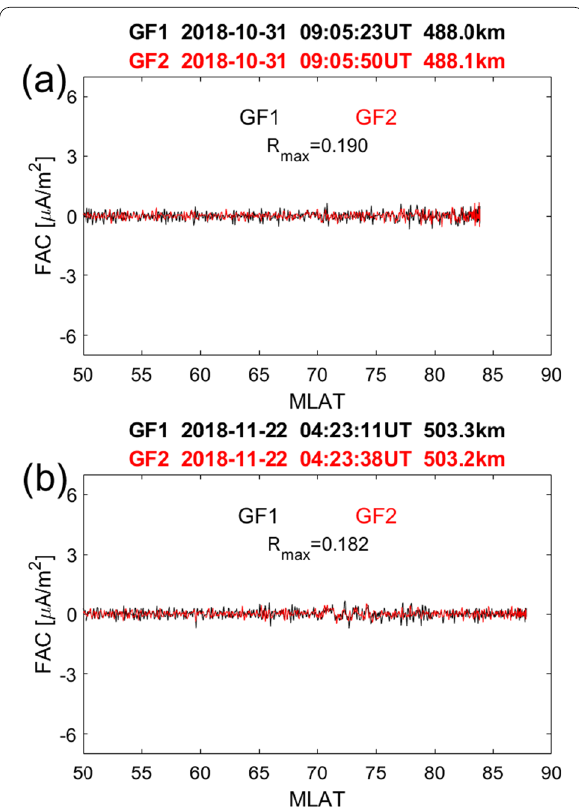
Fig. 3 Two examples of FACs with very low current intensity